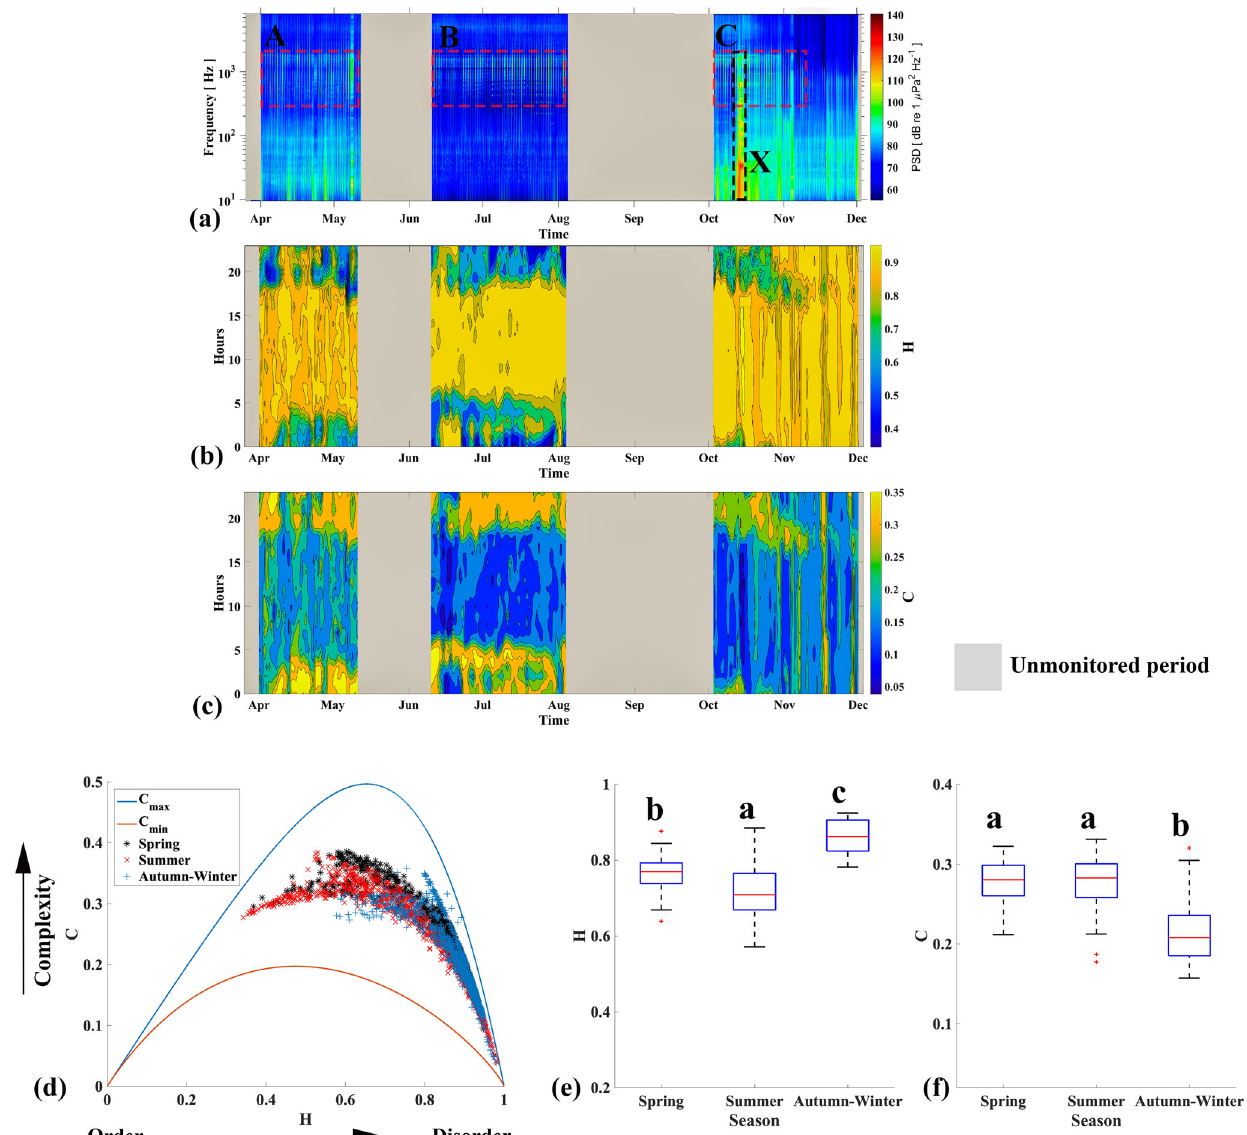
Fig. 2 Seasonal variation of the complexity (C) and regularity (H) of the hourly acoustic PAM data. a Annual spectrogram at the Changhua monitoring site during 2017. The color label represents the power spectral density (PSD) in units of dB re 1 μ Pa 2 Hz − 1 . The labels A, B, and C represent the continuous fi sh chorusing during the spring, summer, and autumn-winter seasons, respectively. The label X represents periods with increased acoustic intensity due to sediment noise. b , c 3-D contour plots showing the distributions of the hourly H and C on a daily basis during 2017. The blue and yellow contours in ( b ) and ( c ) represent the fi sh chorusing. d The hourly variations of C and H during different seasons are plotted on the C-H plane. e , f Comparison of H and C during spring ( n = 41 days), summer ( n = 56 days), and autumn-winter ( n = 60 days). In each box, the central red mark depicts the median, and the top and bottom edges of the box represent the 25th and 75th percentiles. The maximum and minimum values are marked in black at the extreme ends. The symbol ‘ + ‘ represents outliers. Each box with a superscript letter represents the results from a post hoc multiple comparison test. Different superscript letters indicate signi fi cant differences ( p < 0.05), with the letter ‘ a ’ at the top and subsequent statistical differences are represented at a lower